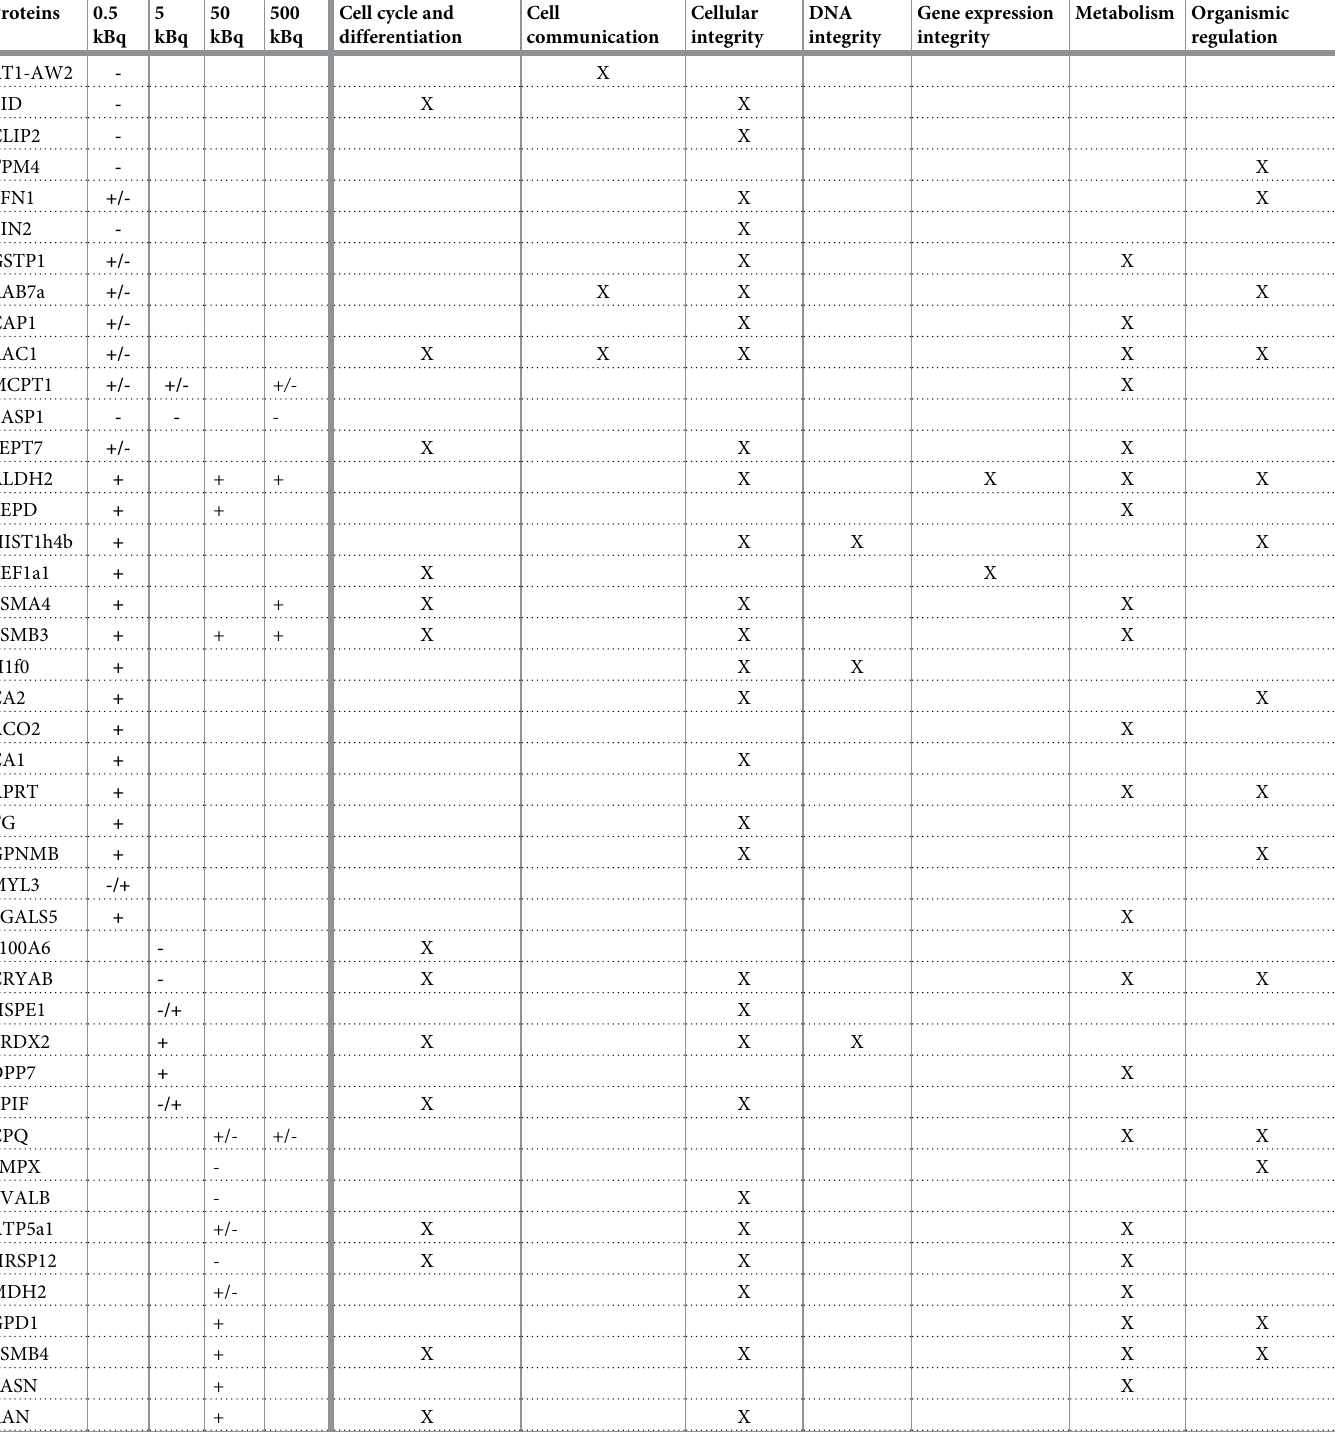
Table 2. Expression of statistically significant regulated proteins in both thyroid and plasma. The figure displays all 63 proteins that were statistically significantly reg- ulated in both thyroid tissue and plasma for the same activity level (0.5, 5, 50 or 500 kBq) nine months after 131I injection. The fold change cut-off was set to ± 1.5. A posi- tive or negative fold change is represented by + and–, respectively. If there was a difference between direction of regulation in thyroid and plasma, the thyroid data is presented first and then the plasma data, separated by /. Associated GO terms are displayed for each protein.